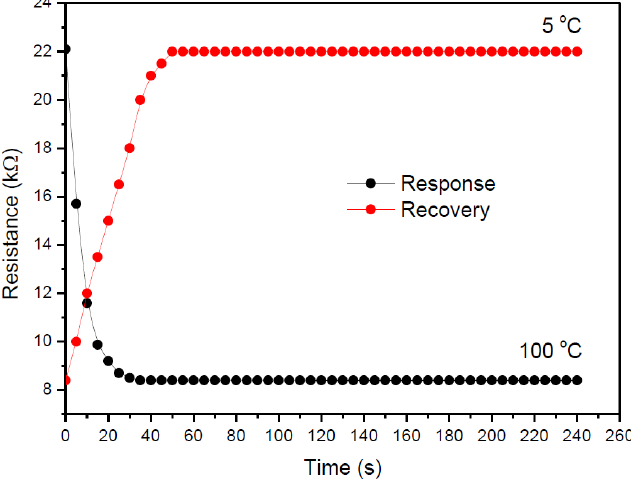
Figure 7. Response and recovery time plot for the cells CuTsPc resistive temperature